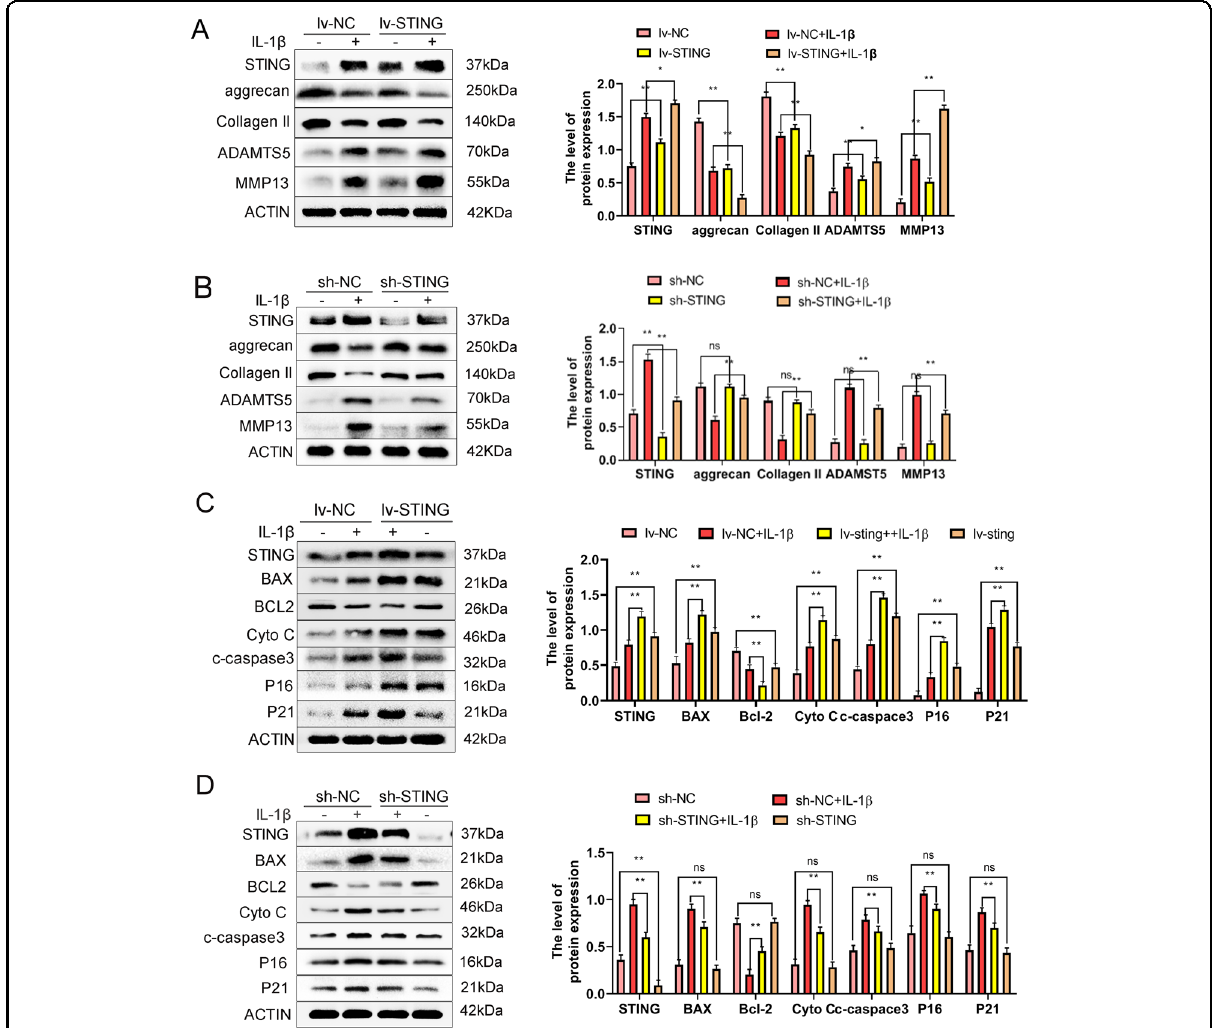
Fig. 3 STING promotes ECM degradation, senescence, and apoptosis in chondrocytes. The mouse chondrocytes were pre-exposed to lv-STING or sh-STING and subsequently by IL-1 β (10 ng/ml) treatment for 24 h. A Western blot, as well as its quanti fi cation revealed the level of STING, Aggrecan, and Collagen II, MMP13 and ADAMTS5 after exposure to IL-1 β (10 ng/ml) or lv-STING. B Western blot along with its quanti fi cation revealed the level of STING Aggrecan, and Collagen II, MMP13 and ADAMTS5 after treatment with IL-1 β or sh-STING. C Western blot along with its quanti fi cation revealed the level of STING, BAX and BCL-2, and Cyto-c, cleaved-caspase-3 and p16INK4a, and p21 after exposure to IL-1 β or lv-STING. D Western blot along with its quanti fi cation revealed the level of STING, BAX, and BCL-2, and cleaved-caspase-3 and p16INK4a, and p21 after exposure to IL-1 β or sh-STING. All data are indicated as mean ± SD ( n = 5); * P < 0.05, ** P <